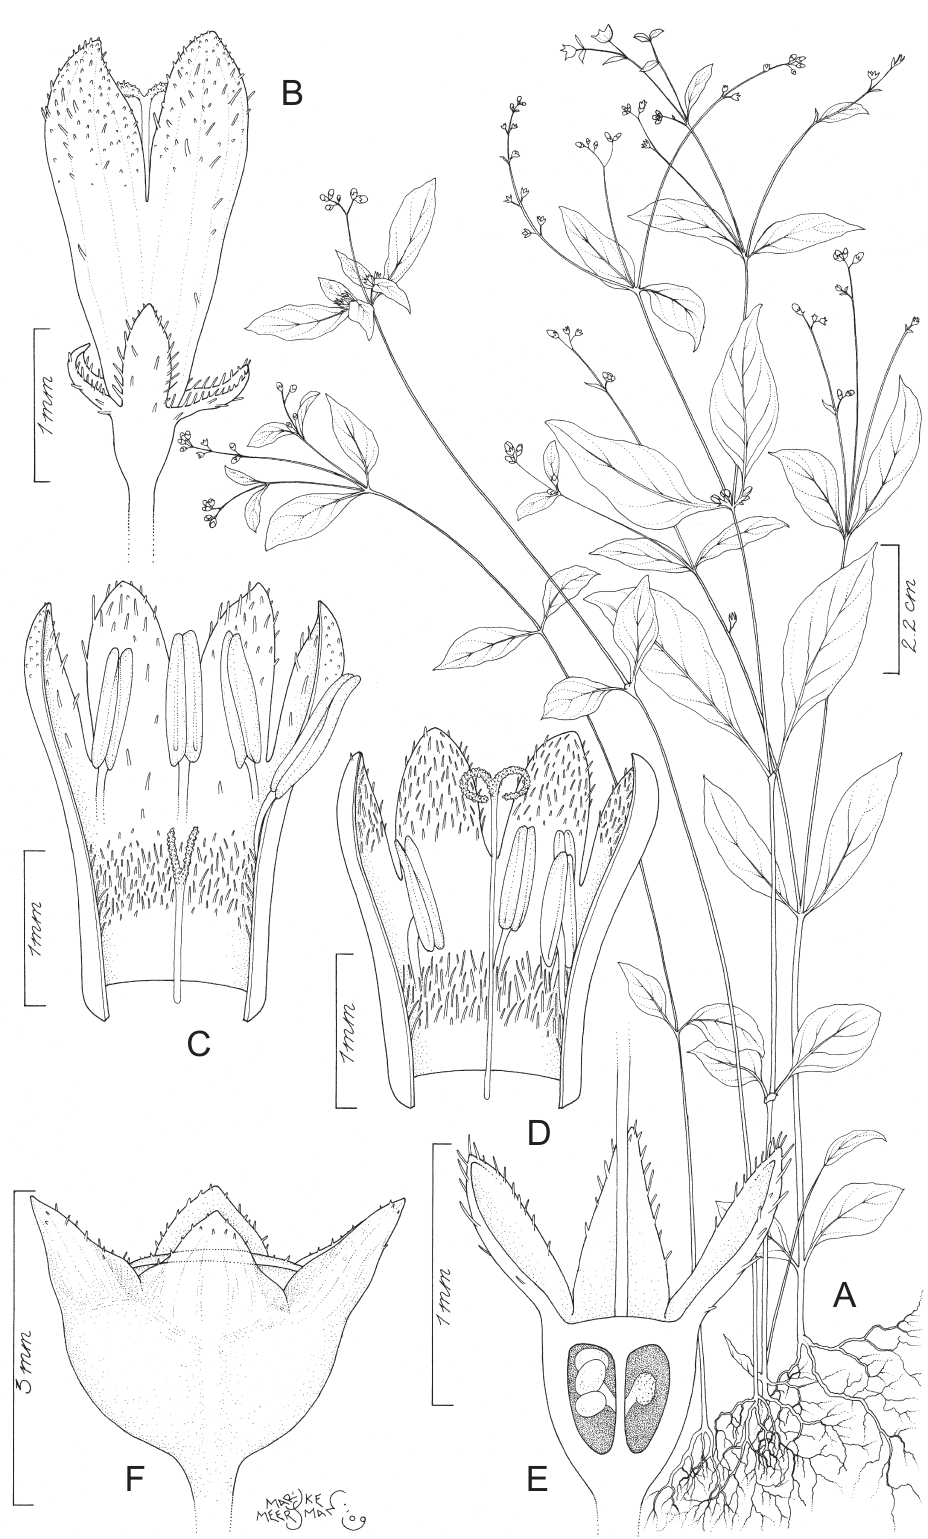
Fig. 3. Astiella antsalovansis Groeninckx sp. nov. A . Habit. B . Longistylous flower. C . Open brevistylous flower. D . Open longistylous flower. E . Ovary dissected to show placentation. F . Capsule. Drawn by Marijke Meersman. A–E from Morat 4805 (P); F from Villiers, Klackenberg & Badre 4788